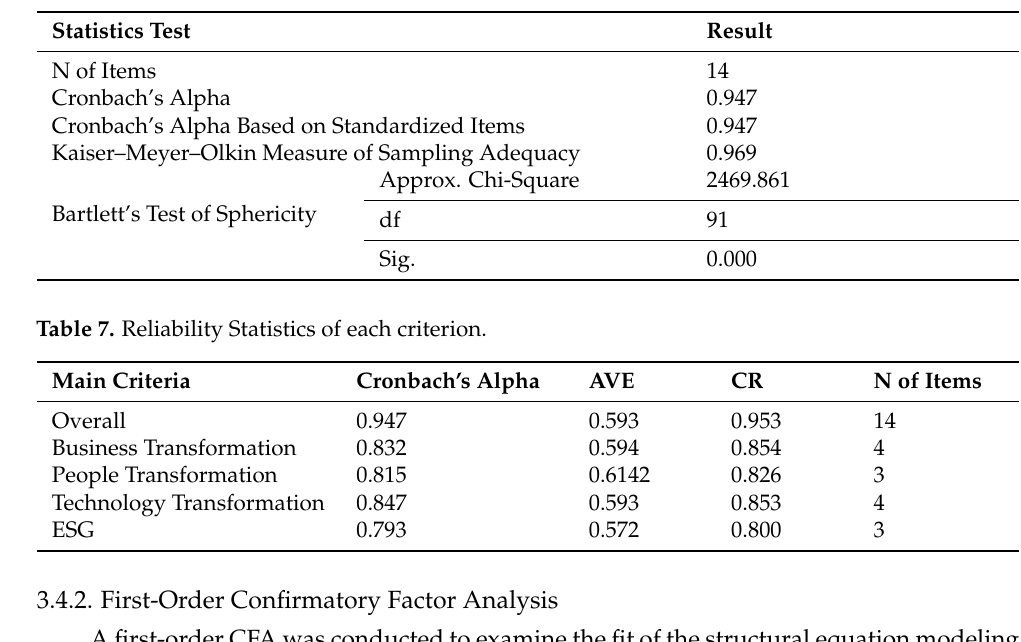
Table 6. Bartlett’s test, validity, and reliability statistics.